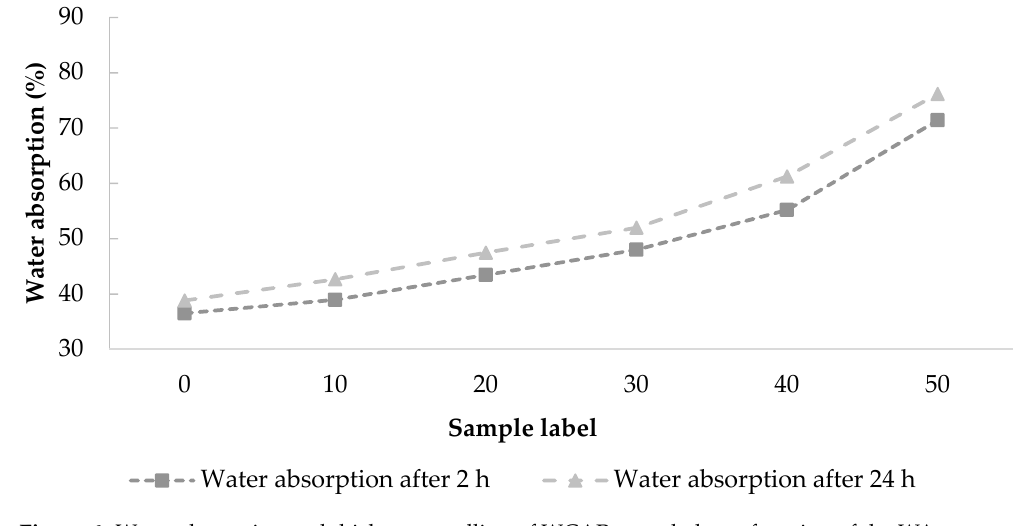
Table 6. Average water absorption and swelling of WCAP as a function of the WA content.